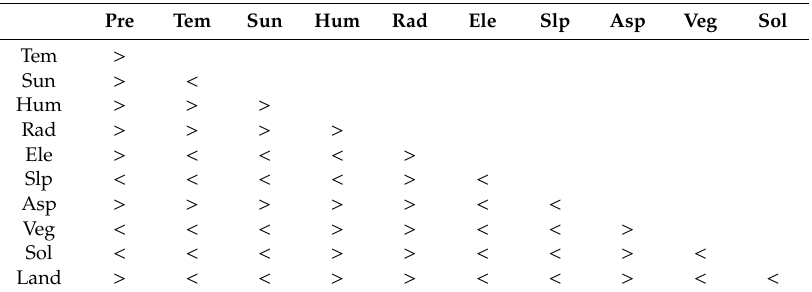
Table 7. Comparison of factor interactions.